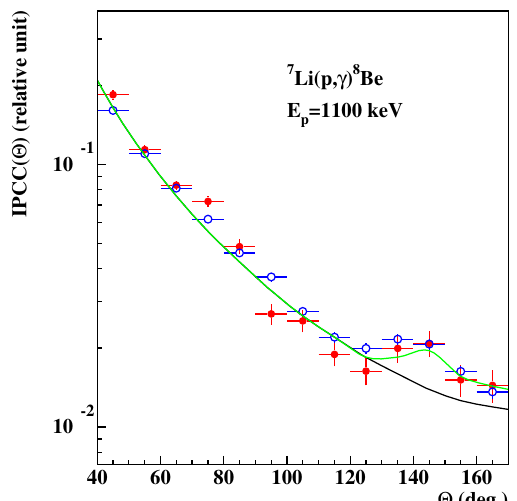
Figure 3. Results from the 8 Be. Background, shown by the solid black line, is estimated by a fourth order exponential polynomial. The green solid line shows simulation results, which include the decay of the boson. Red dots with error bars shows the results from the latest experiment [2] for the 8 Be 18.15 MeV transition, while blue circles with error bars show the previous results [1]